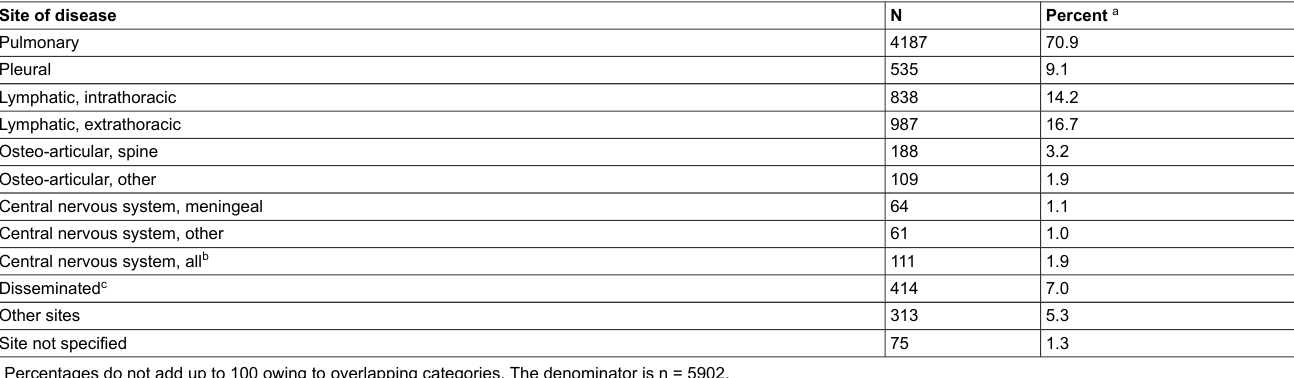
Table 2: Site of disease, tuberculosis cases in Switzerland and Liechtenstein, 2009–2019.